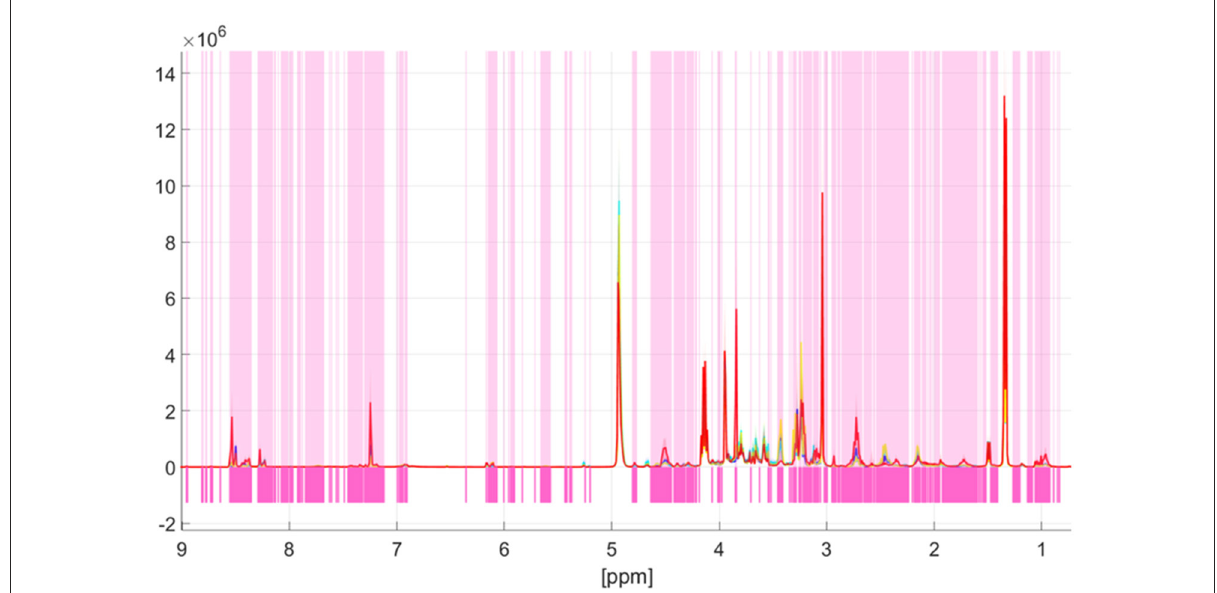
FIGURE3 Identification of spectroscopic regions that are responsible for the discrimination of the meat species pork, lamb, beef, and poultry. The p -values according to the Kruskal-Wallis test are color coded (white: high p -value, magenta: low p -value). Low p -values indicate spectral regions containing information that contribute to the discrimination. Meat species are marked as follows: poultry—red; beef—turquoise; lamb—yellow; pork—blue. The thick line describes the respective mean value of each individual group, the colored areas around the respective mean value show ranges of variation within a